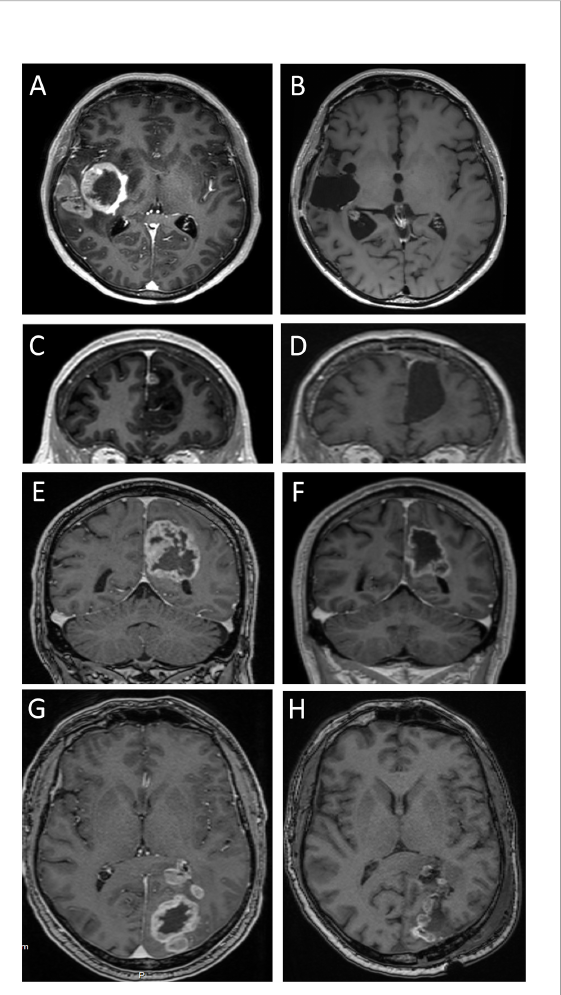
FIGURE 5 Four solid glioblastomas before and after tumor surgery. T1- weighted MPRAGE MRIs were obtained after intravenous injection of gadolinium-based contrast medium (which gives a bright, ring-formed signal in most images). Images (A, C, E, G) show pre-surgical MRIs. Tumors in images (A , C) were assessed as having minimal mass effect. Note the modest displacement of surrounding brain tissue (compare with contralateral side). Tumors in images (E , G) were assessed as having moderate and pronounced mass effect, respectively. Images (B, D, F, H) show MRIs after 400, 167, 26, and 4 days, respectively. Note the absence of brain tissue where the tumor resided. This includes both white matter and the overlying